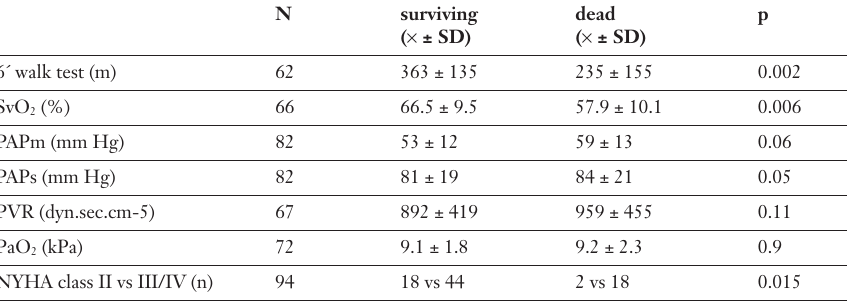
Comparative parame- ters between dead and surviving pa- tients with PH. SvO 2 = mixed venous oxygen saturation, PAPm = mean pul- monary artery pres- sure, PAPs = systolic pulmonary artery pressure, PVR = pul- monary vascular resistance, N = num- ber of patients tested.